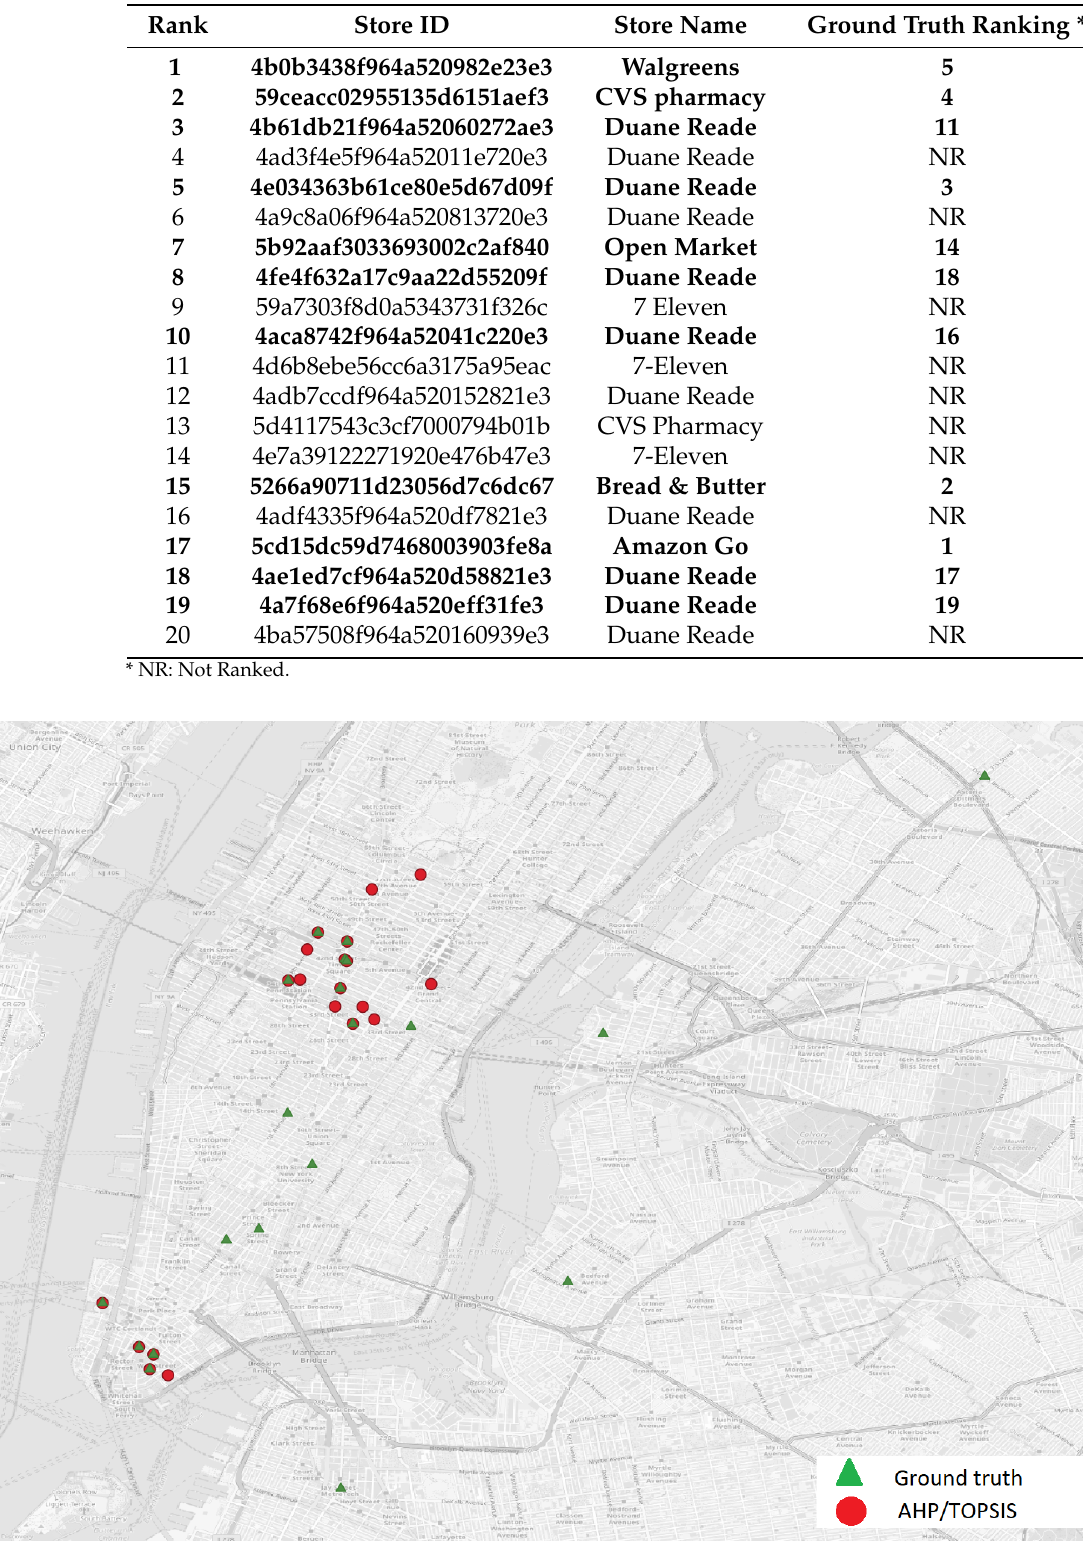
Table 9. AHP/TOPSIS—stores ranked obtained using the AHP/TOPSIS approach.